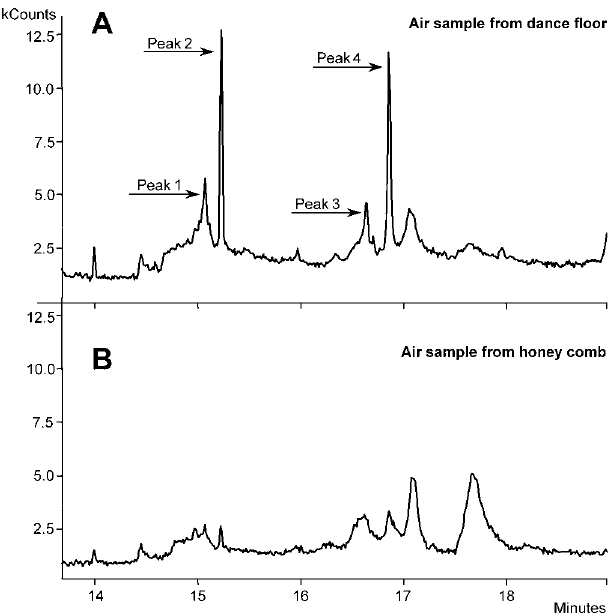
Figure 1. Comparison of Air Samples above Waggle Dancers and Nondancing Bees A chromatogram of an air sample taken from the dance-floor area on the bottom hive frame, where waggle dancers were present (A) and of a sample from the top frame, where honey was stored and no waggle dancers (but other bees) were present (B). Relative amount of fragments is measured in thousands of counts. Peaks 1, 2, 3, and 4 are Z-(9)- tricosene, tricosane, Z-(9)-pentacosene and pentacosane, respectively, and these peaks distinguish the air over dancing bees from the air over nondancing